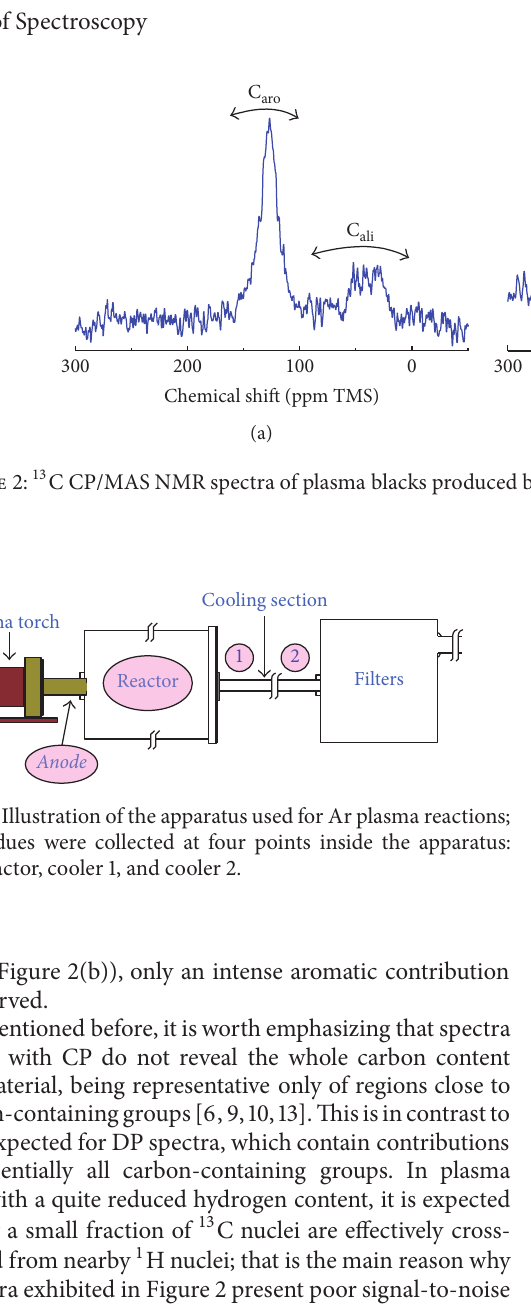
Figure 3: Illustration of the apparatus used for Ar plasma reactions; solid residues were collected at four points inside the apparatus: anode, reactor, cooler 1, and cooler